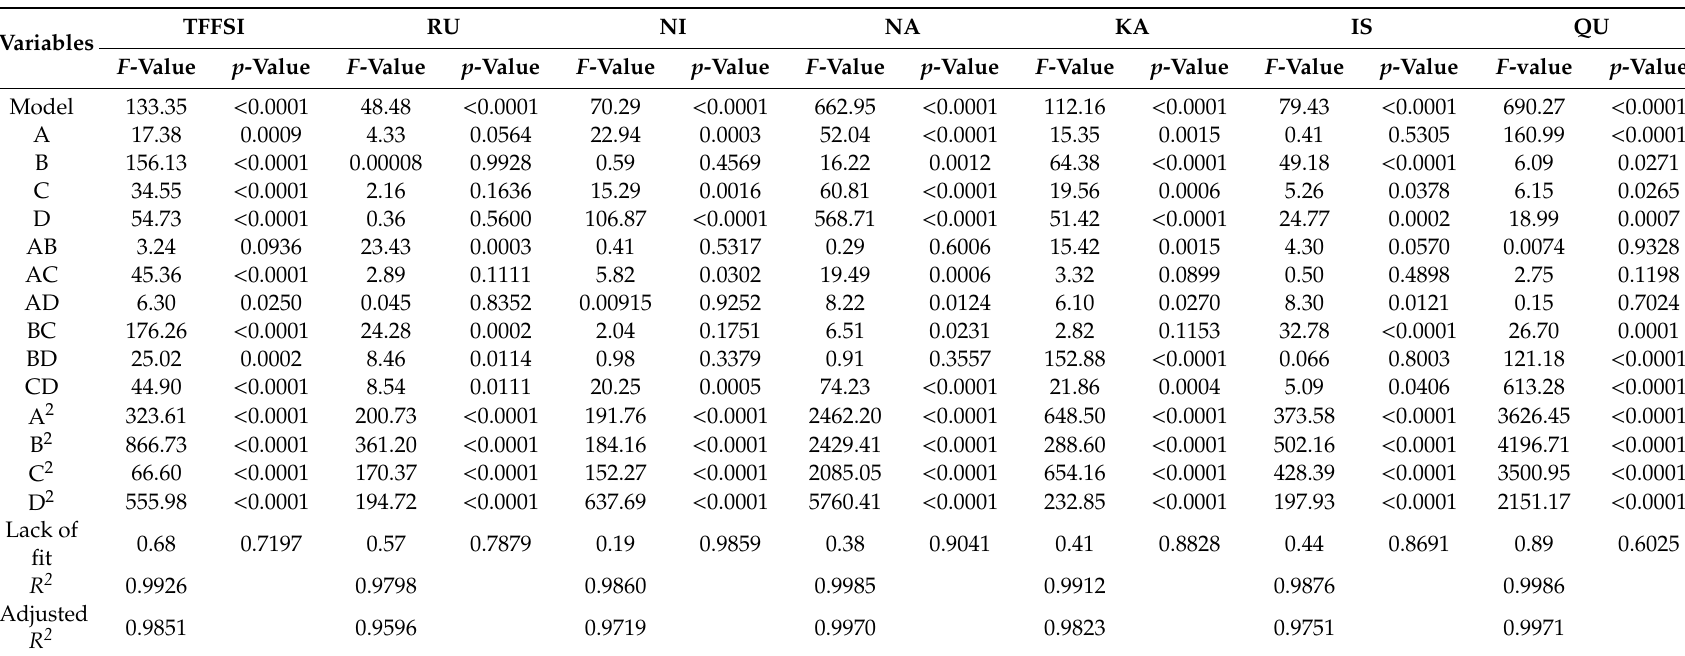
Table 2. Analysis of variance (ANOVA) statistics of the regression model for the extraction rates of RU, NI, NA, KA, IS, QU, and the